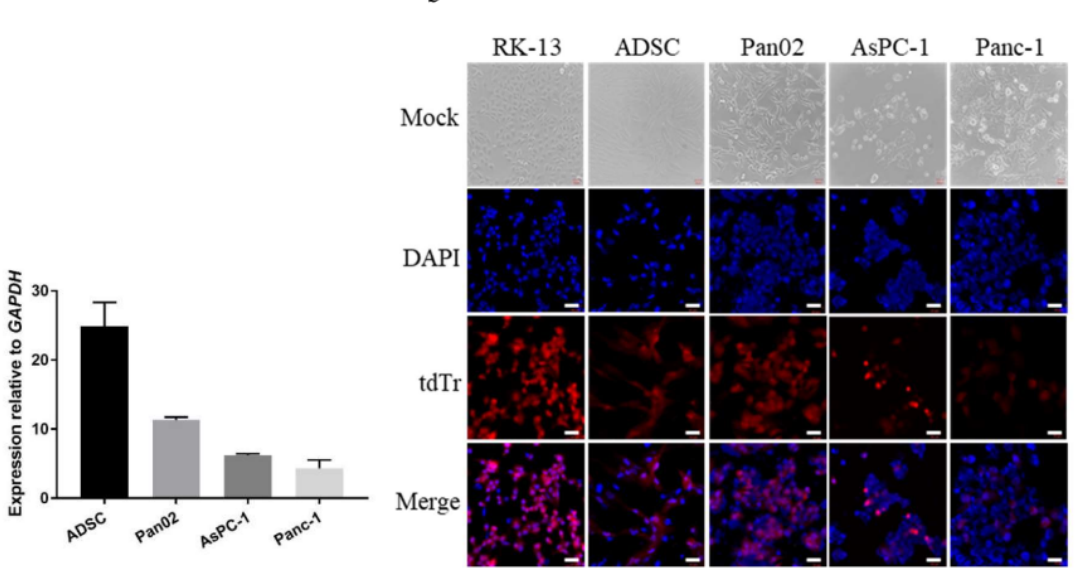
Figure 1. Early and late gene expression following infection of various cell lines with LIGHT-encoding myxoma construct. Cultures of ADSCs, Pan02, RK13, AsPC-1 and Panc-1 were infected with vMyx- mLIGHT-FLuc/tdTr (MOI = 5). ( a ) Constitutive expression of LIGHT gene in infected ADSCs and pancreatic cancer cell lines at 24 h p.i. LIGHT gene transcript was measured using RT-qPCR, and expression was rendered as a ratio of target gene (LIGHT) vs. reference gene (glyceraldehyde 3- phosphate dehydrogenase / GAPDH /). The data show mean ± SD of two independent experiments. ( b ) Infection visualized at 24 h p.i. by fluorescence microscopy (magn. 20 × ; scale bar = 50 µ m; Zeiss LSM 710 confocal Workstation); blue: DAPI staining (nuclei); red: tdTr